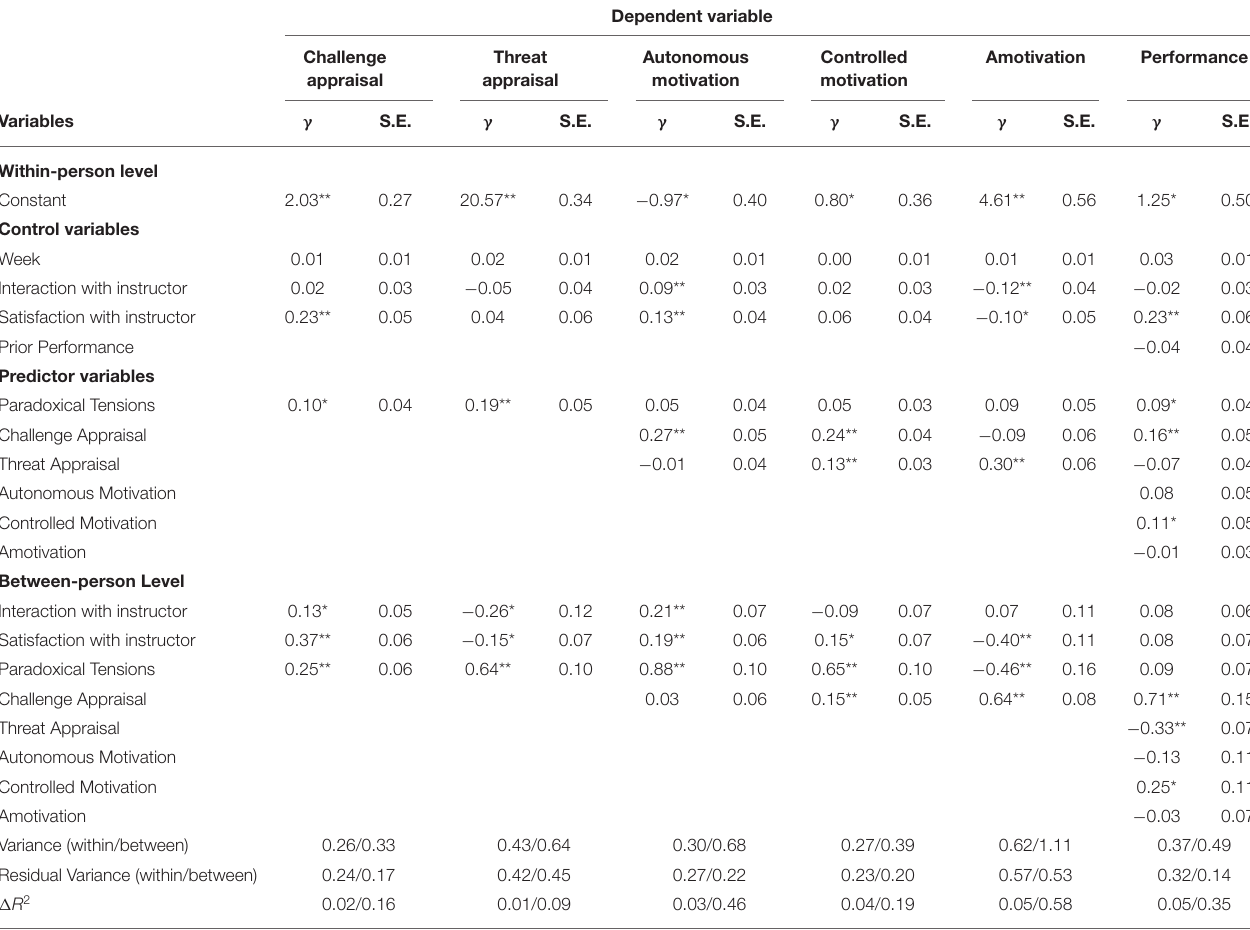
N = 178,numberofobservations = 1,355;samplesizeissmallerforlaggedanalyses;unstandardizedregressioncoefficientsarereported.Regressioncoefficientsremainrobustwithout including control variables. * p < 0.05, ** p < 0.01, Two-tailed test. The effect of paradoxical tensions on weekly